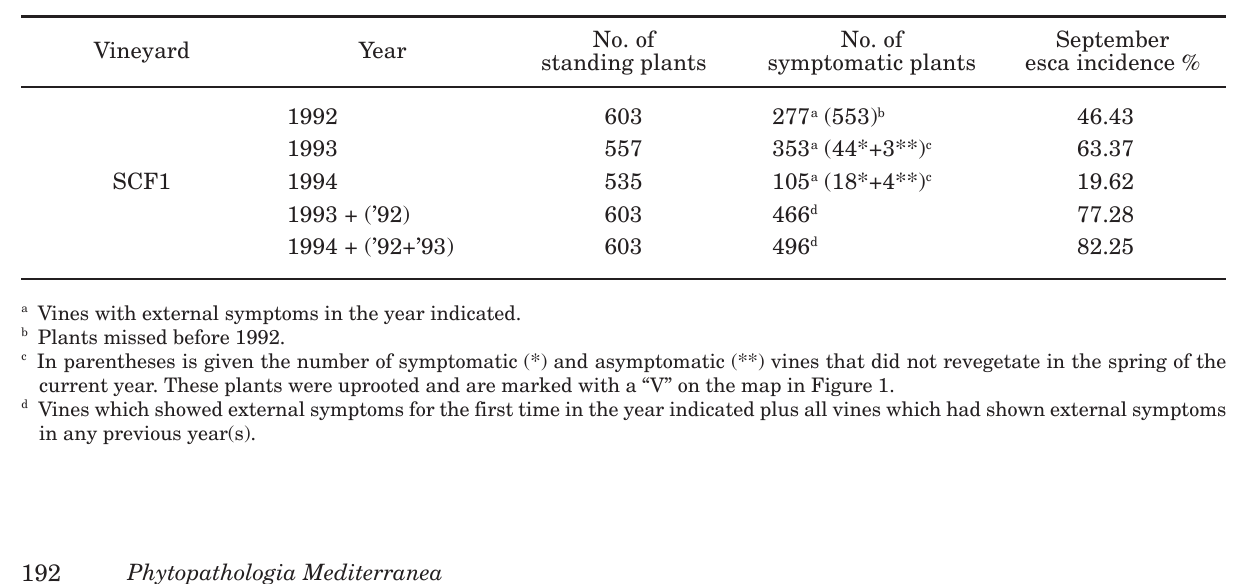
Table 1. Characteristics of five vineyards surveyed for esca. (For explanation of acronyms refer to text). Characteristic